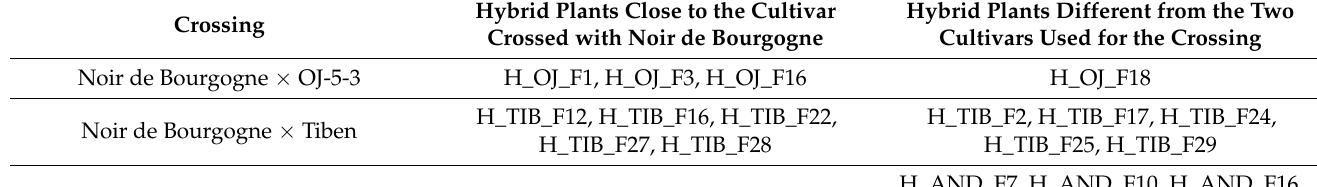
Hybrid Plants Different from the Two Cultivars Used for the